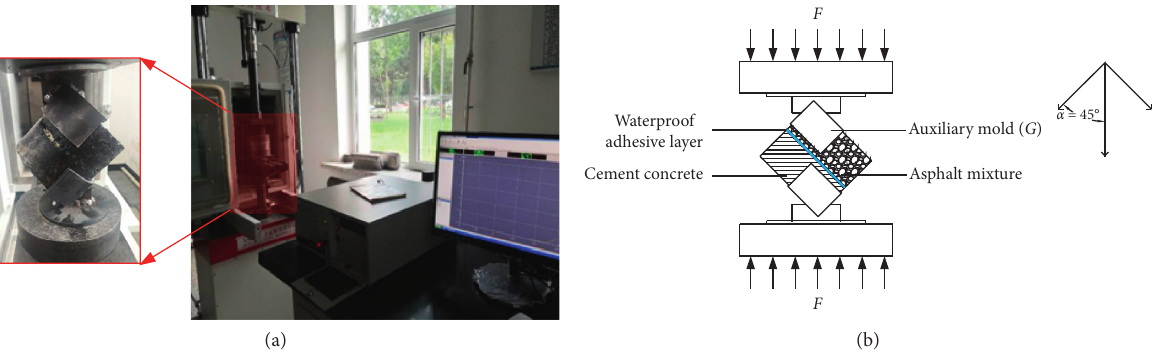
Figure 2: Shear test of the composite bridge deck structure. (a) Shear test in this paper. (b) The diagram of the shear